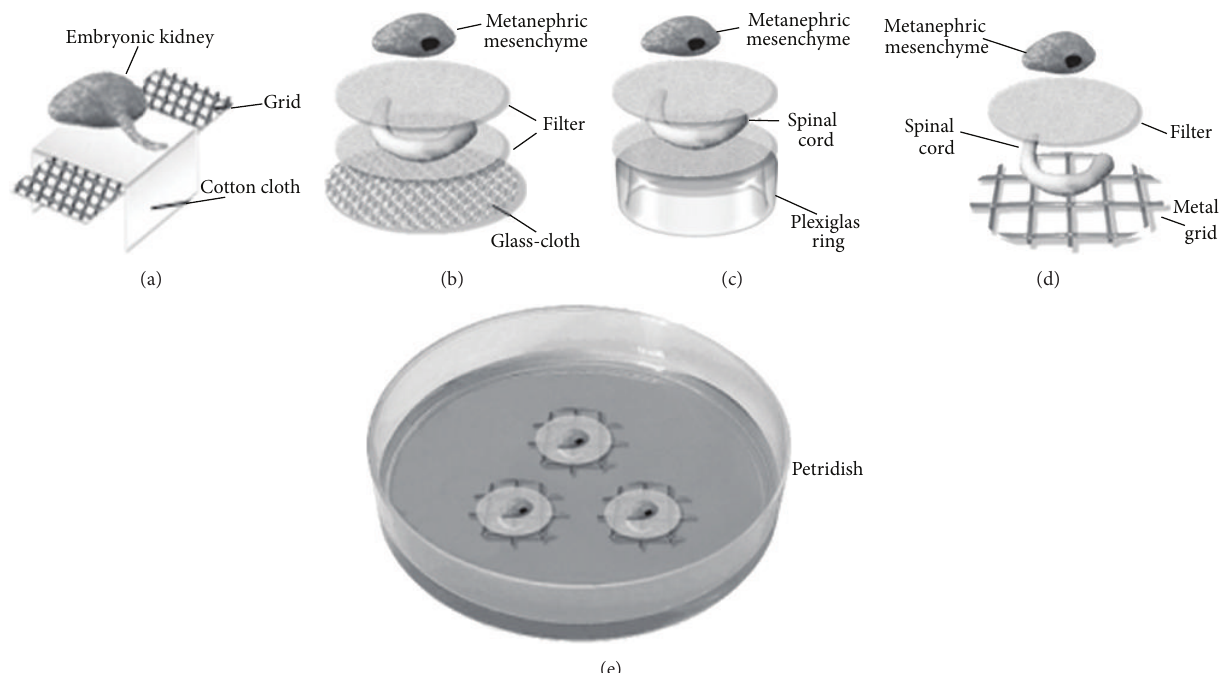
Figure 1: Method setup, from Trowel to Saxen: in 1954 Trowell introduced a new method to culture whole organs. He used a metal grid in support of a cotton sheet or filter that would hold the embryonic kidney; the cotton sheet was soaked with culture medium (see (a)) [2]. Culture medium was added only to the level of the grid to cover the tissue with a thin layer of the medium due to surface tension [2]. This set up became very useful to studying aspects of nutrition and metabolism in vitro (a). One year later in 1956, Grobstein slightly modified the method and introduced the “on-the-cloth” (see (b)) and “supported-ring” (c) methods [22]. Both methods used the embryonic spinal cord (eSC) from mouse [43] as inducer. The noninduced mesenchyme was placed on a filter, and a second filter was used to support the eSC. The layout was later called “sandwich type culture . ” The “on-the-cloth” method used glass-cloth as a support for the tissue cultures on the filters (as in (b)) and the “supported-ring” used a Plexiglas ring onto which the filters were cemented (c). In 1962, Saxen combined and simplified these methods (d). He cultured the noninduced mesenchyme and spinal cord separated by a filter [22] on a metal grid [2] to support the tissues on the filter in a simple culture dish (e) [117]. Saxen’s modernization has been well taken by others and it is still successfully used